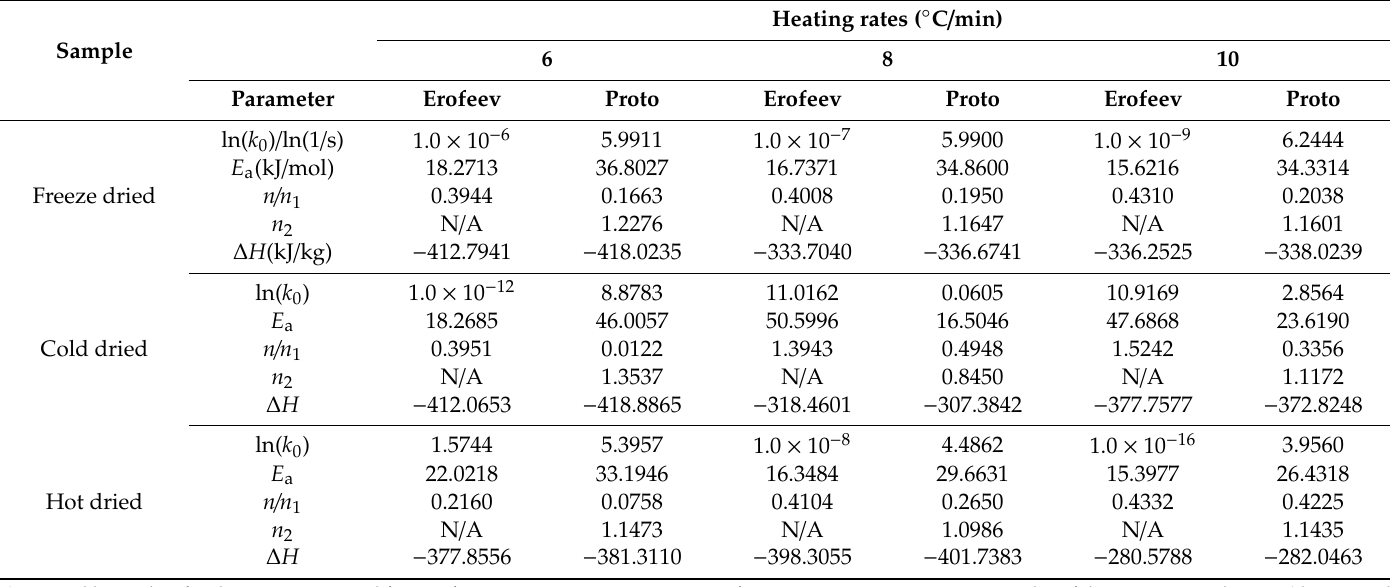
Table 5. Moisture capacity kinetic simulation results of di ff erential scanning calorimetry (DSC) (closed system) analyses for various drying